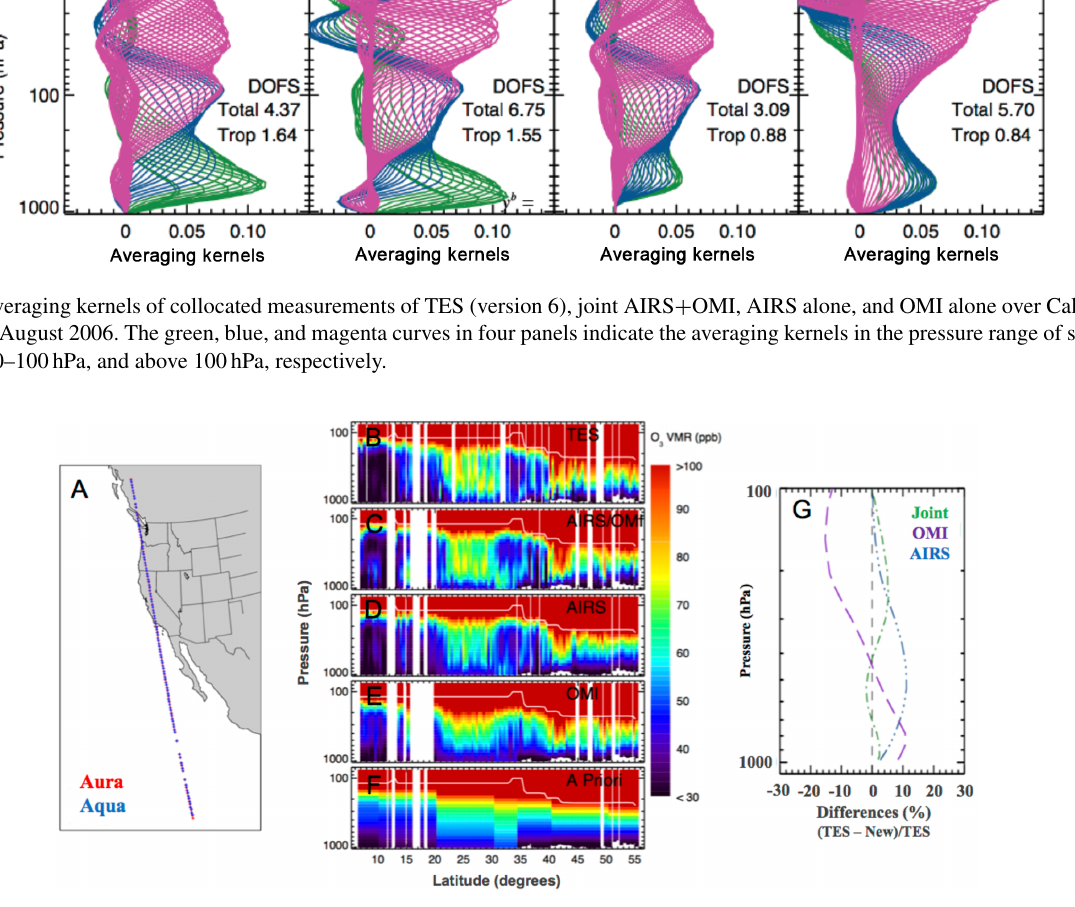
Figure 2. Collocated ozone (O 3 ) measurements from A-Train nadir-viewing spectrometers over the western United States on 23 August 2006. (A) Geolocation of 110 TES–AIRS–OMI triads (spatiotemporal differences ∼ 8km, ∼ 16min); (B) vertical profile of TES O 3 volume mixing ratio (VMR) data (version 6) in units of parts per billion (ppb); (C) joint AIRS + OMI retrievals; (D) AIRS alone; (E) OMI alone; (F) a priori used in retrievals; and (G) averaged percentage differences of retrieved O 3 profiles in comparison to TES O 3 data (version 6): TES vs. joint AIRS + OMI (green dash-dotted line), TES vs. AIRS alone (blue), and TES vs. OMI alone (purple dashed line). The white curves in the panels of (B–F) indicate the tropopause pressure taken from the Goddard Earth Observing System Model, Version